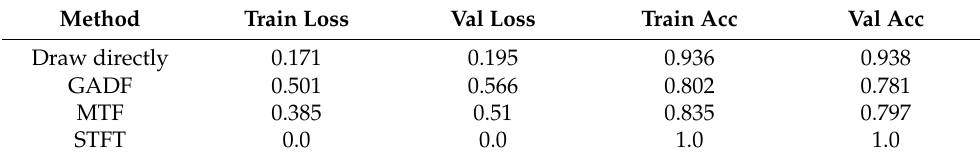
Figure 12. Final loss and accuracy of four methods. Table 3. Final loss and accuracy of single-channel dataset in